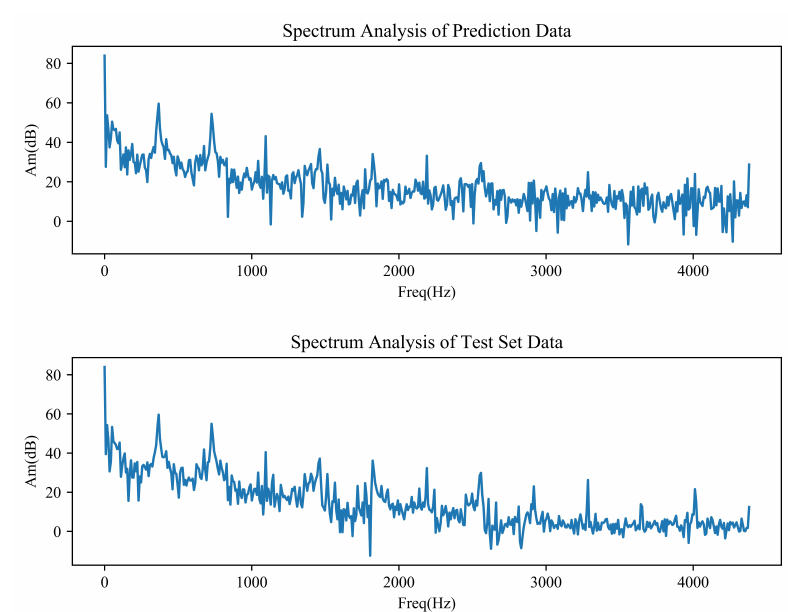
Figure 11. Amplitude Spectrum of ISO-NE Dataset. Freq: the hourly data in frequency domain (1/Hour); Am: the amplitude of data in both datasets.